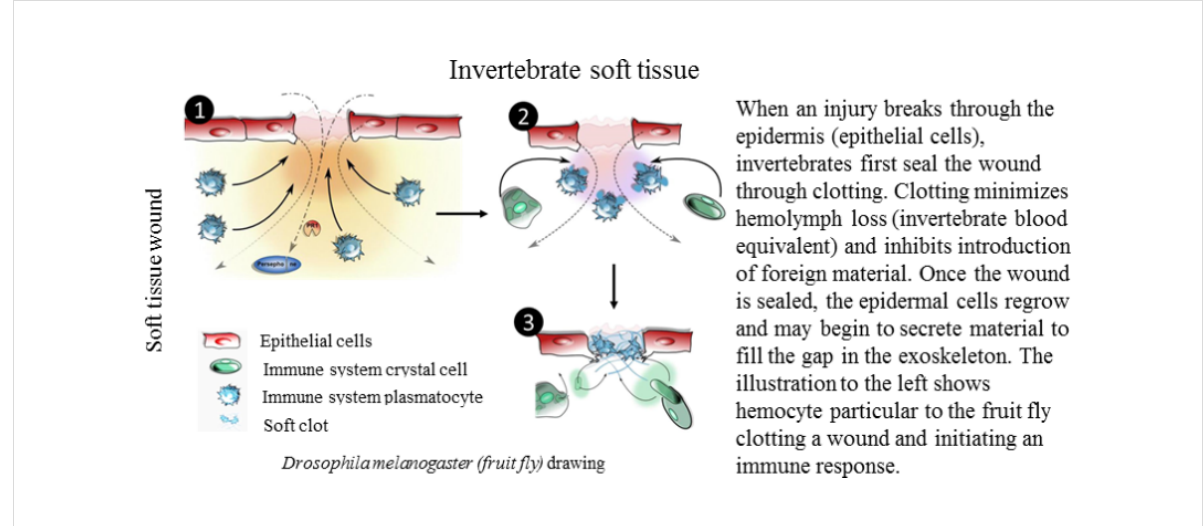
Figure 6: Healing response to invertebrate soft tissue wounds. Invertebrates rely on quickly clotting wounds to stem loss of hemolymph, which can quickly become fatal in their open circulatory systems. Adapted from [47].